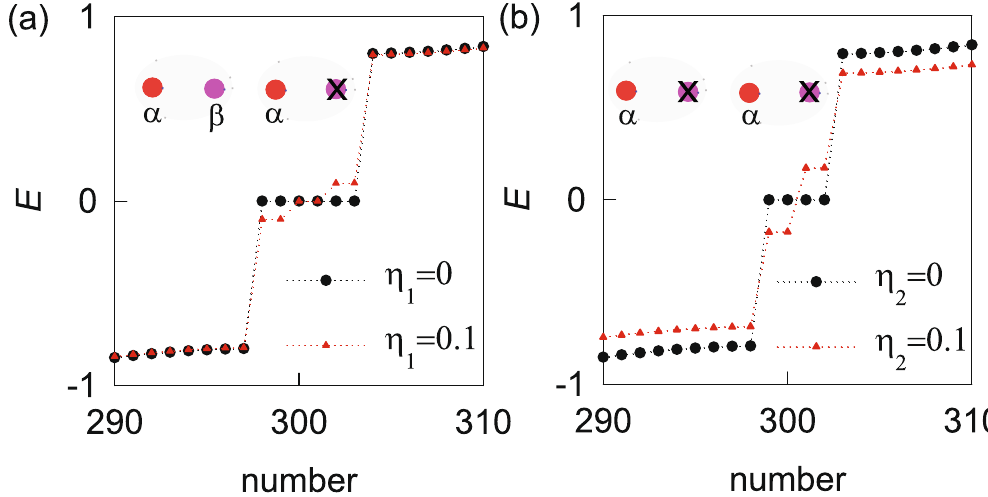
Figure 5. The open energy spectrum for the case of three Majorana chains. ( a ) The effect of NN hopping term in the topological phase with two α and one β Majorana zero modes at each end. ( b ) The effect of NNN hopping term in the topological phase with two α Majorana fermions at each end. The parameters in ( a ) are: ′ = . ′ = . t t 0 3, 0 9 and in ( b ) are: ′ = . ′ = . t t 0 9, 0 3 , η 1 = 0.1. The other parameters are t 1 = 0.2, t 2 = 1, 1 2 1 2 ″ = . ″ = . t . The insets schematically show the left boundary zero modes in the absence of the symmetry 2 breaking